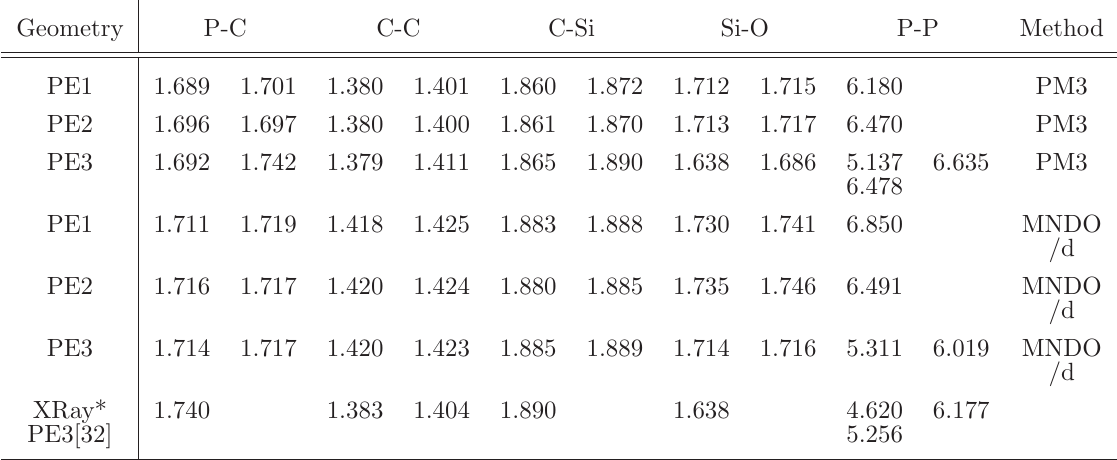
Table 1 PM3 and MNDO/d calculation for bond length of phosphinine-ether macrocycles (˚A)[41,